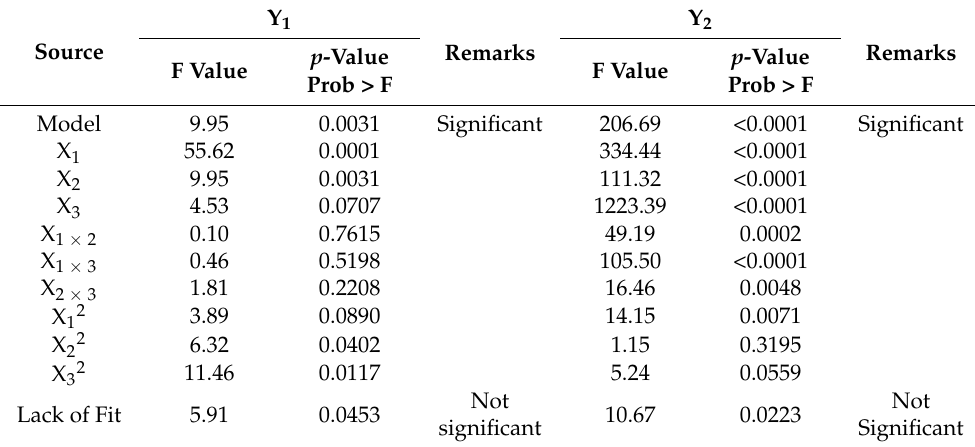
Table 4. Analysis of variance for BBD.